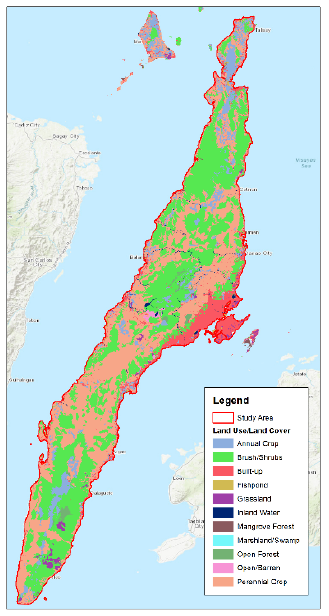
curve number of 73 characterizing brushlands with an HSG